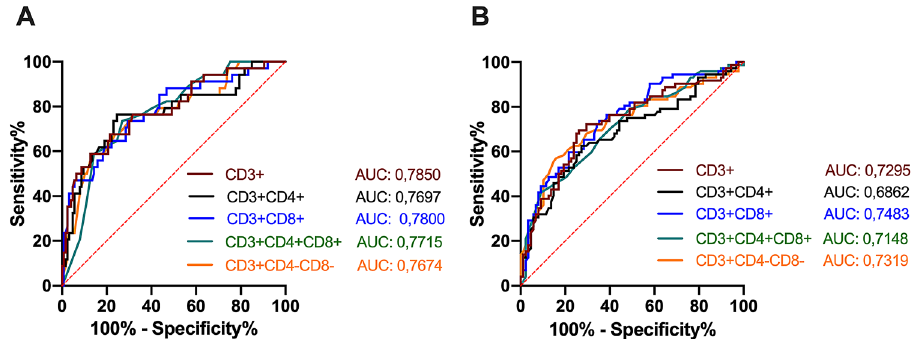
Figure 2. ROC analysis of T-lymphocyte subset absolute counts for in-hospital mortality and disease severity of COVID-19 patients. Receiver operating characteristic (ROC) curves are represented for total CD3+ and four subsets of T lymphocyte cells. Cutoff values were identified with the Youden’s index. ( A ) ROC analysis showing the performance of baseline absolute counts of total T lymphocyte and their subsets in distinguishing fatal cases from survivors. Cutoff values for: CD3+: 524 cells/µl, sensitivity 67,65%, specificity: 78.57%, AUC: 0.7850, p < 0.0001; CD3 + CD4+: < 369 cells/µl, sensitivity 76.47%, specificity: 75.40%, AUC: 0.7697, p < 0.0001; CD3 + CD8+: < 194 cells/µl, sensitivity 73.53%, specificity: 70.63%, AUC: 0.7800, p < 0.0001; CD3 + CD4 + CD8 + DP: < 6.5 cells/µl, sensitivity 73.53%, specificity: 73.02%, AUC: 0.7715, p < 0.0001; CD3 + CD4 − CD8 − DN: < 21.5 cells/µl, sensitivity 76.47%, specificity: 68.25%, AUC: 0.7674, p < 0.0001. ( B ) ROC analysis showing the performance of baseline absolute counts of total T lymphocytes and their subsets in distinguishing severe (NRM, NIV and OTI) from nonsevere (AA and VMK) cases. Cutoff value for: CD3+ : < 733 cells/µl, sensitivity 69.44%, specificity: 73.86%, AUC: 0.7295, p < 0.0001; CD3 + CD4+ : < 426 cells/ µl, sensitivity 62.50%, specificity: 72.73%, AUC: 0.6862, p < 0.0001; CD3 + CD8+ : < 262 cells/µl, sensitivity 73.61%, specificity: 64.77%, AUC: 0.7483, p < 0.0001; CD3 + CD4 + CD8 + DP: < 4.5 cells/µl, sensitivity 41.67%, specificity: 90.91%, AUC: 0.7148, p < 0.0001; CD3 + CD4 − CD8 − DN: < 18.5 cells/µl, sensitivity 56.94%, specificity: 84.09%, AUC: 0.7319, p < 0.0001. AUC area under the curve, AA ambient air, VMK Venturi mask, NRM nonrebreather oxygen mask with concentrator, NIV noninvasive mechanical ventilation, OTI Orotracheal Intubation for mechanical